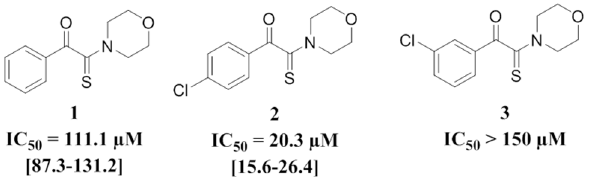
Figure 2. α -ketothioamide inhibitors and preliminary SAR investigations .